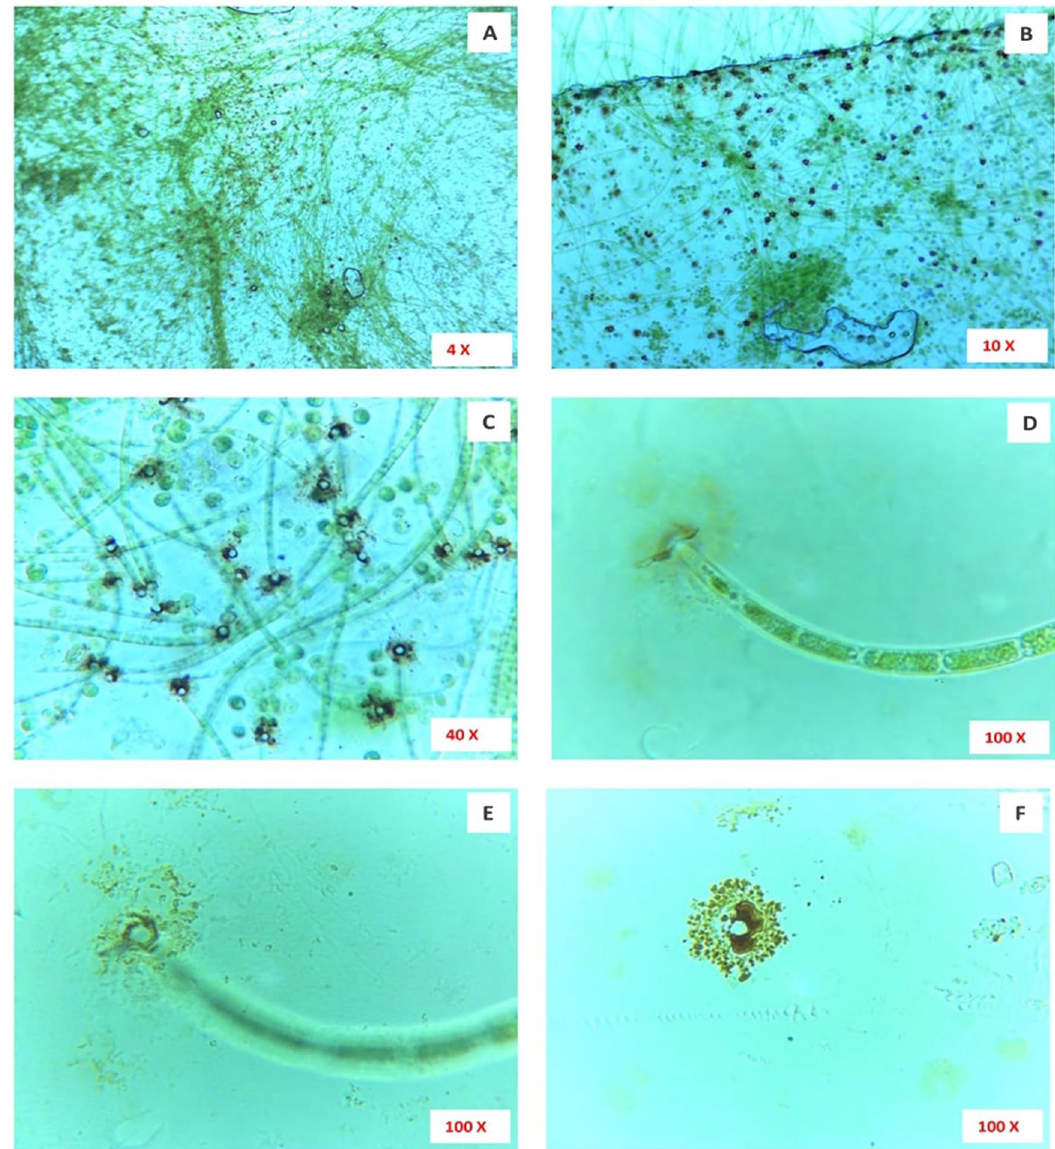
Figure 9. The microscopic images showing colonization of microalga Uronema africanum on the surface of LDPE sheet. ( A ) The × 4 magnification image showing small dot-like structures and hair-like structures on the LDPE sheet; ( B ) In × 10 magnification, the hair-like structures are nothing but the filamentous structures of the microalga Uronema africanum protrude from the black dots; ( C ) The × 40 magnification of microalga treated LDPE sheet; ( D ) The × 100 magnification illustrates a single filament found attached to the LDPE sheet by forming a radial disc-like structure by the basal cell; (E) The radial disc is clearly focused in × 100 magnification; ( F ) The radial disc without microalgal